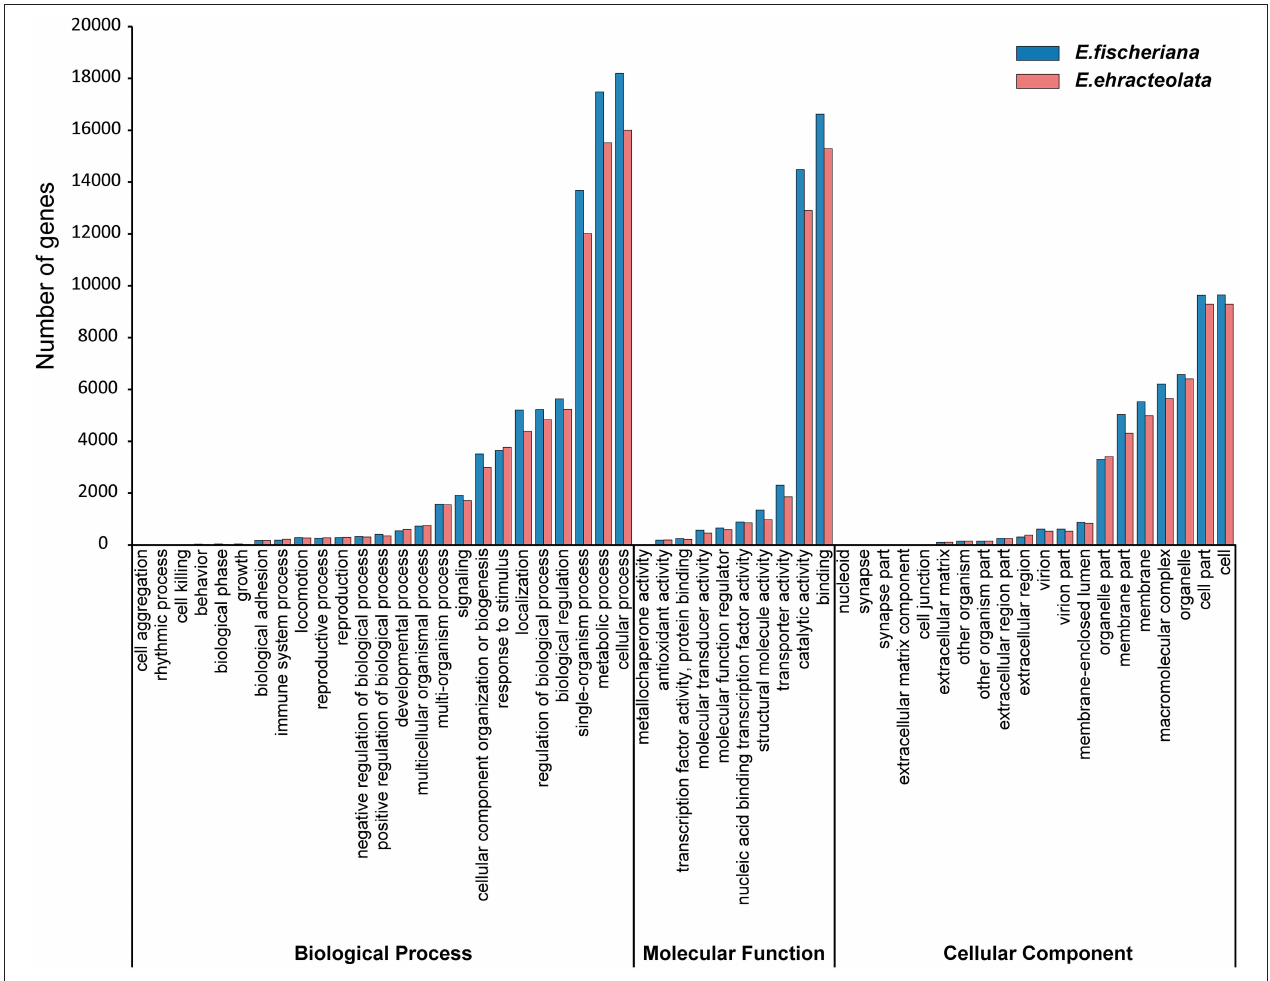
FIGURE 2 | Functional annotation of assembled sequences based on gene ontology (GO) categorization.